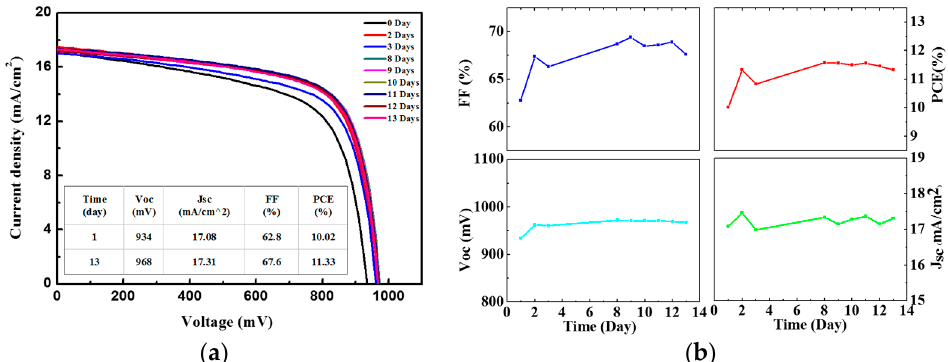
8 of 11 Figure 6. AFM images of the surface of the TiO 2 layers sprayed by the TiO 2 ethanol solution with the addition of TAA, ( a ) ITO sheet without TiO 2 film; ( b ) 1.0 mol % TAA; ( c ) 2.0 mol % TAA; and ( d ) 3.0 mol % TAA with respect to the TiO 2 content. The devices with the highest performance were prepared based on the TiO 2 compact layer sprayed using the TiO 2 solution with 1.0 mol % of TAA. The highest PCE of 14.32% was achieved, with a V oc of 1.008 mV, a J sc of 20.82 mA/cm 2 , and a FF of 68.3%. The improvement of the performance was attributed to the addition of TAA, which enhanced the connection of the TiO 2 nanoparticles. However, the addition of TAA increased the roughness of the film, which had a negative influence on the preparation of the perovskite. It was also observed that the hysteresis of the PSCs increased with the addition of TAA (Figure 5). To study the stability of PSCs based on ultrasonically sprayed TiO 2 , a typical PSC on ITO-glass was placed in a N 2 -filled glove box for long-duration stability testing. The PSC showed a good stability, as shown in Figure 7. The PCE of the device increased after two days, which can be attributed to the increase of the FF, caused by the enhancement of the connection between the TiO 2 particles and the oxidation of the Spiro-OMeTAD. The optimized process of the ultrasonic spraying of 1.0 mg/mL TiO 2 solution with an addition of 1.0 mol % TAA was employed to fabricate PSCs on the flexible ITO-PEN substrate. A photographic image of the flexible device with a large area of 5.0 cm × 5.0 cm is shown in Figure 8a. The best-performing cell exhibited an outstanding photovoltaic performance with a V oc of 945 mV, a